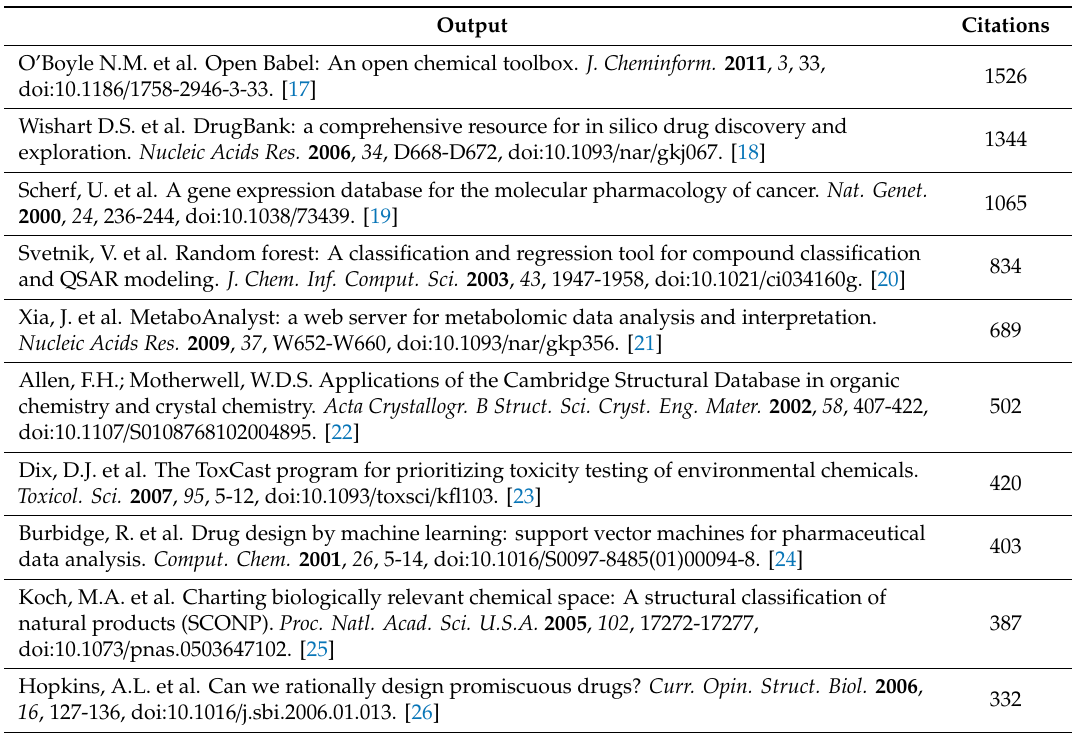
Table 4. Chemoinformatics articles attracting the largest numbers of